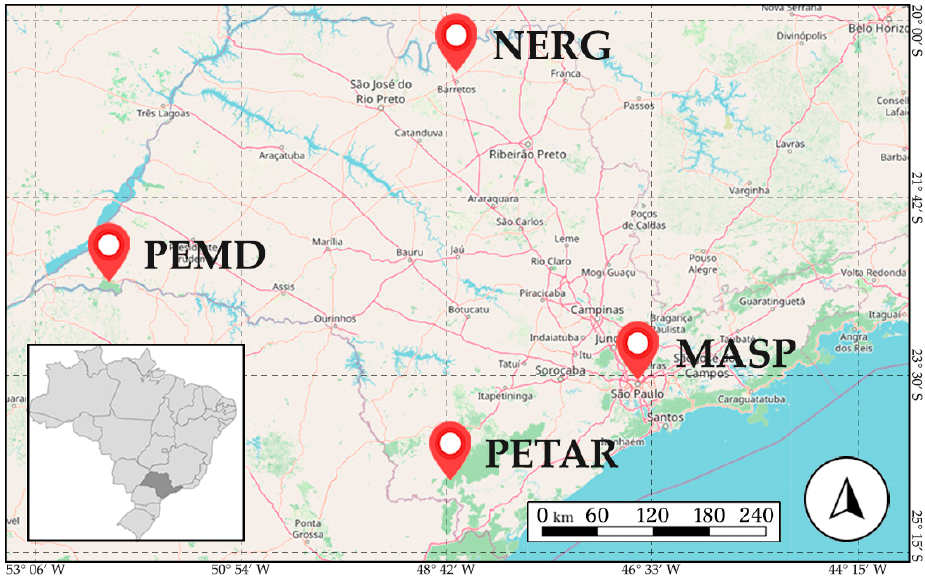
Figure 2. Location of the four areas of interest in the São Paulo